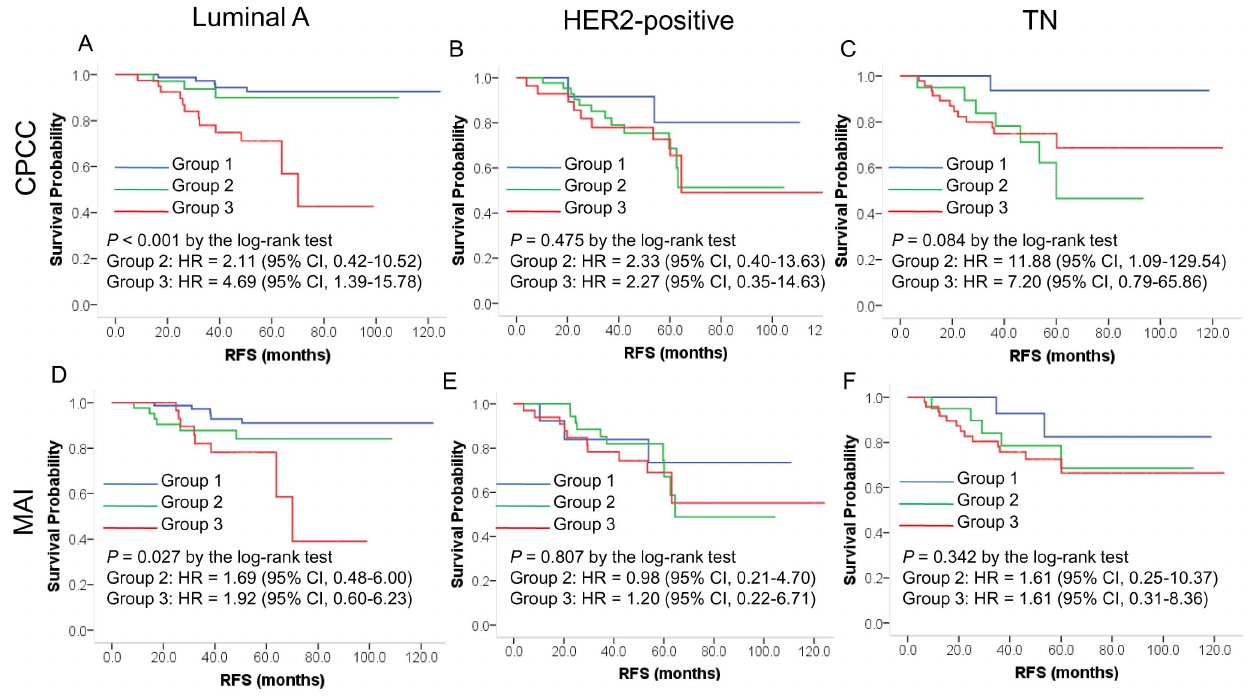
Figure 4. Prognostic significance of proliferation activity in breast cancer subgroups. Shown are Kaplan-Meier CPCC plots for the luminal A (A), HER2-positive (B), and TN (C) subgroup cases, as well as MAI plots for the luminal A (D), HER2-positive (E), and TN (F) subgroup cases. The P values were determined by log-rank test, and the hazard ratios (HRs) and their 95% confidence interval (CI) by the Cox proportional hazard regression model according to the co-variables of age, T stage, N stage, institution, and year of surgical resection. The X-axis is RFS in months, and the Y-axis, RFS probability. CPCC = chromatin CKAP2-positive cell count; MAI = mitotic activity index.